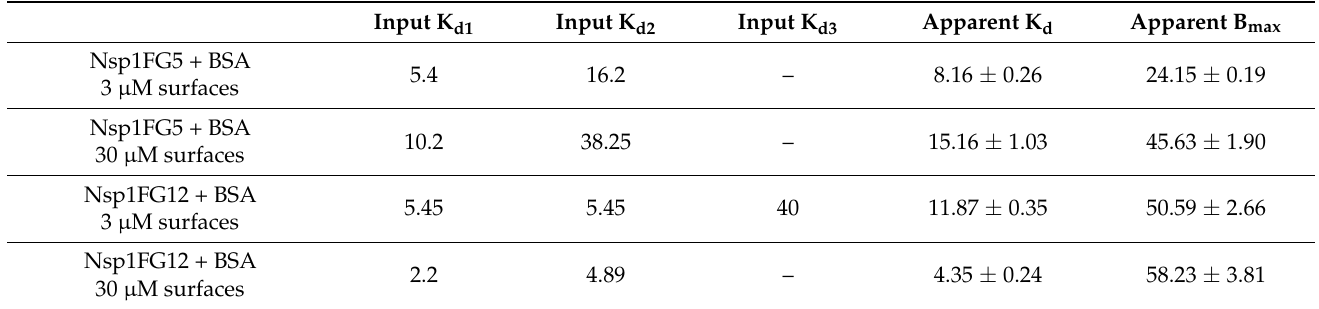
Table 2. Obtained values for binding between NTF2-YFP and Nsp1FG fragments from the ABM